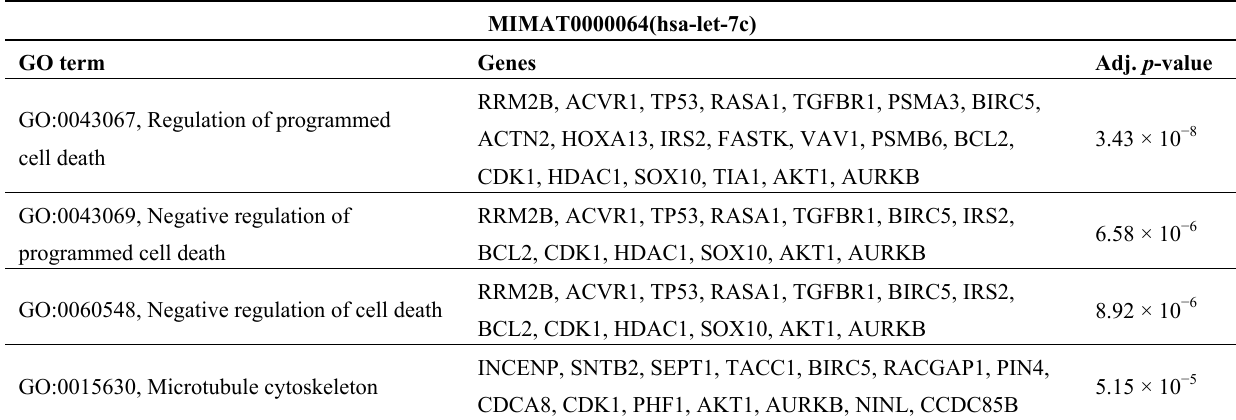
Table 1. Selected enriched functions of let-7c. Member genes of the let-7c-regulated network annotated with corresponding enriched functions are